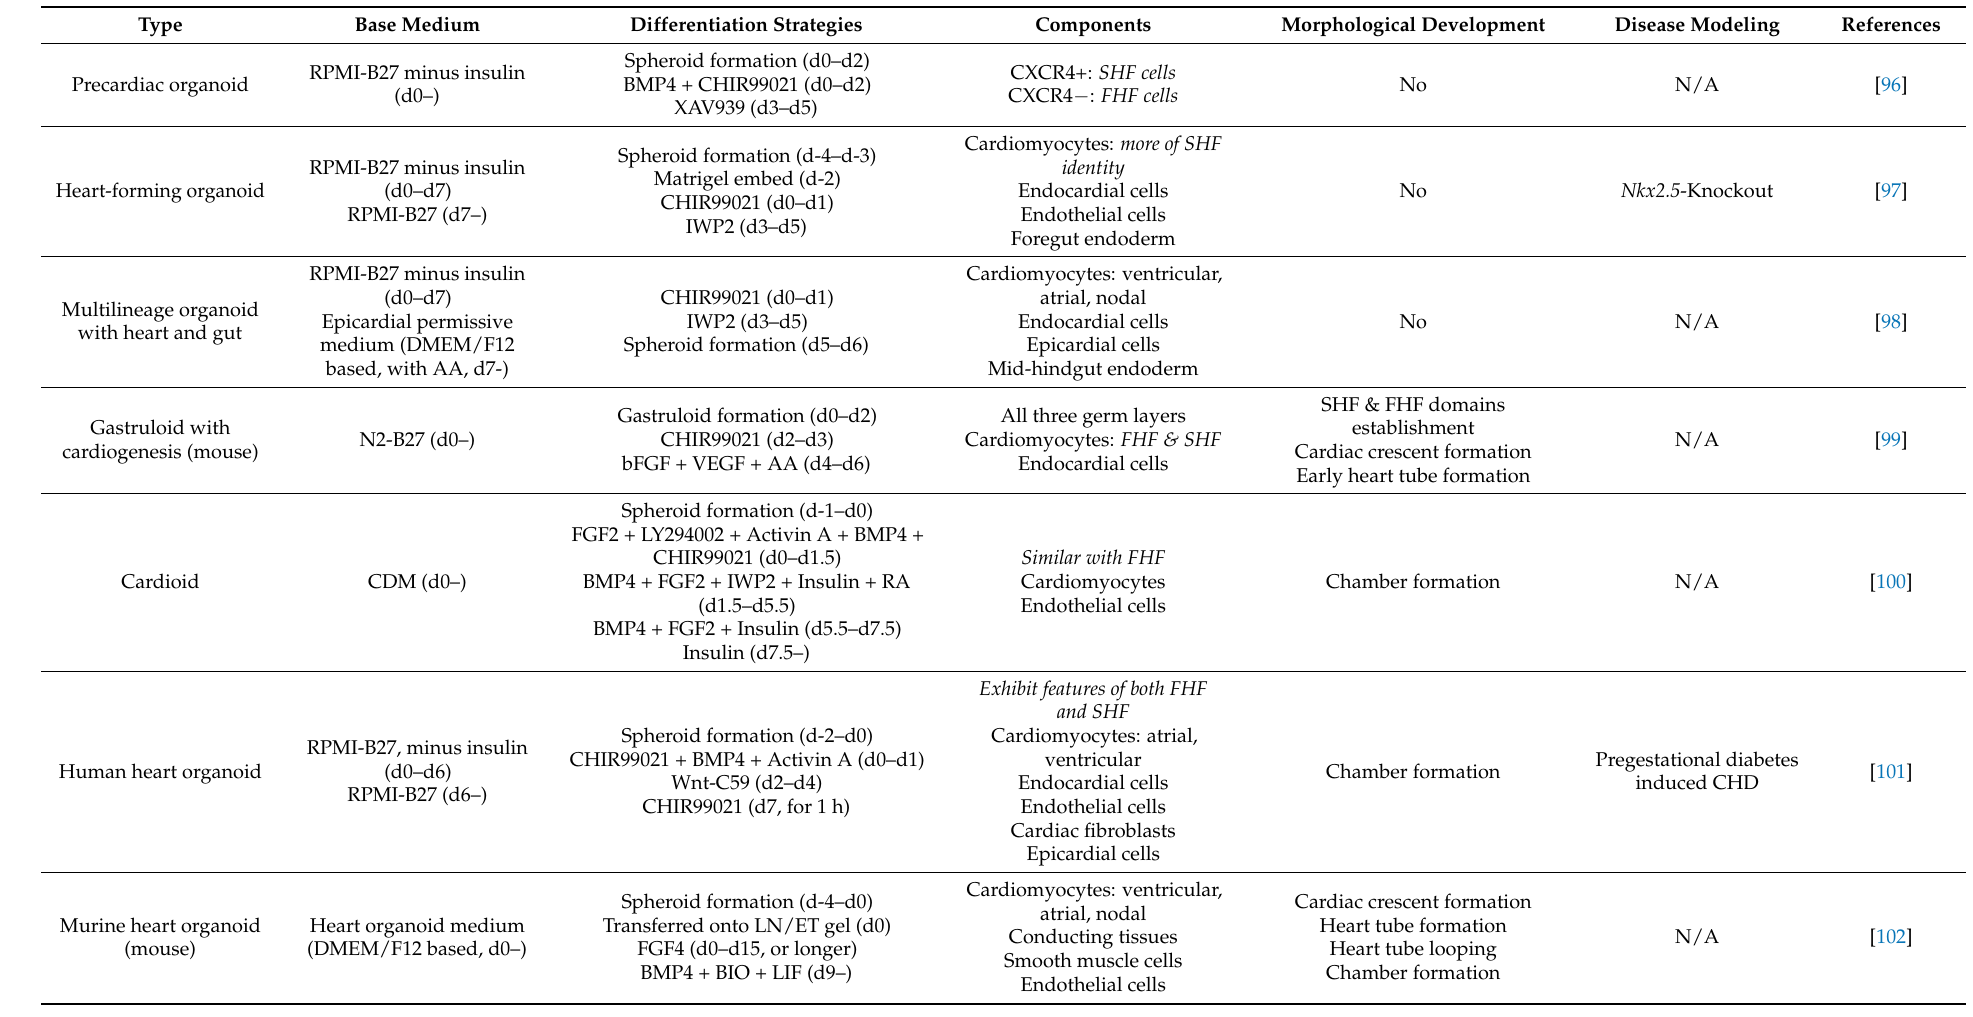
Table 3. Summary of three dimensional (3D) methods for hPSC-based models. D0 marks the start of differentiation. D0-D1 is referred as the first 24 h, D1-D2 as the next 24 h, and so on. See the corresponding reference for more